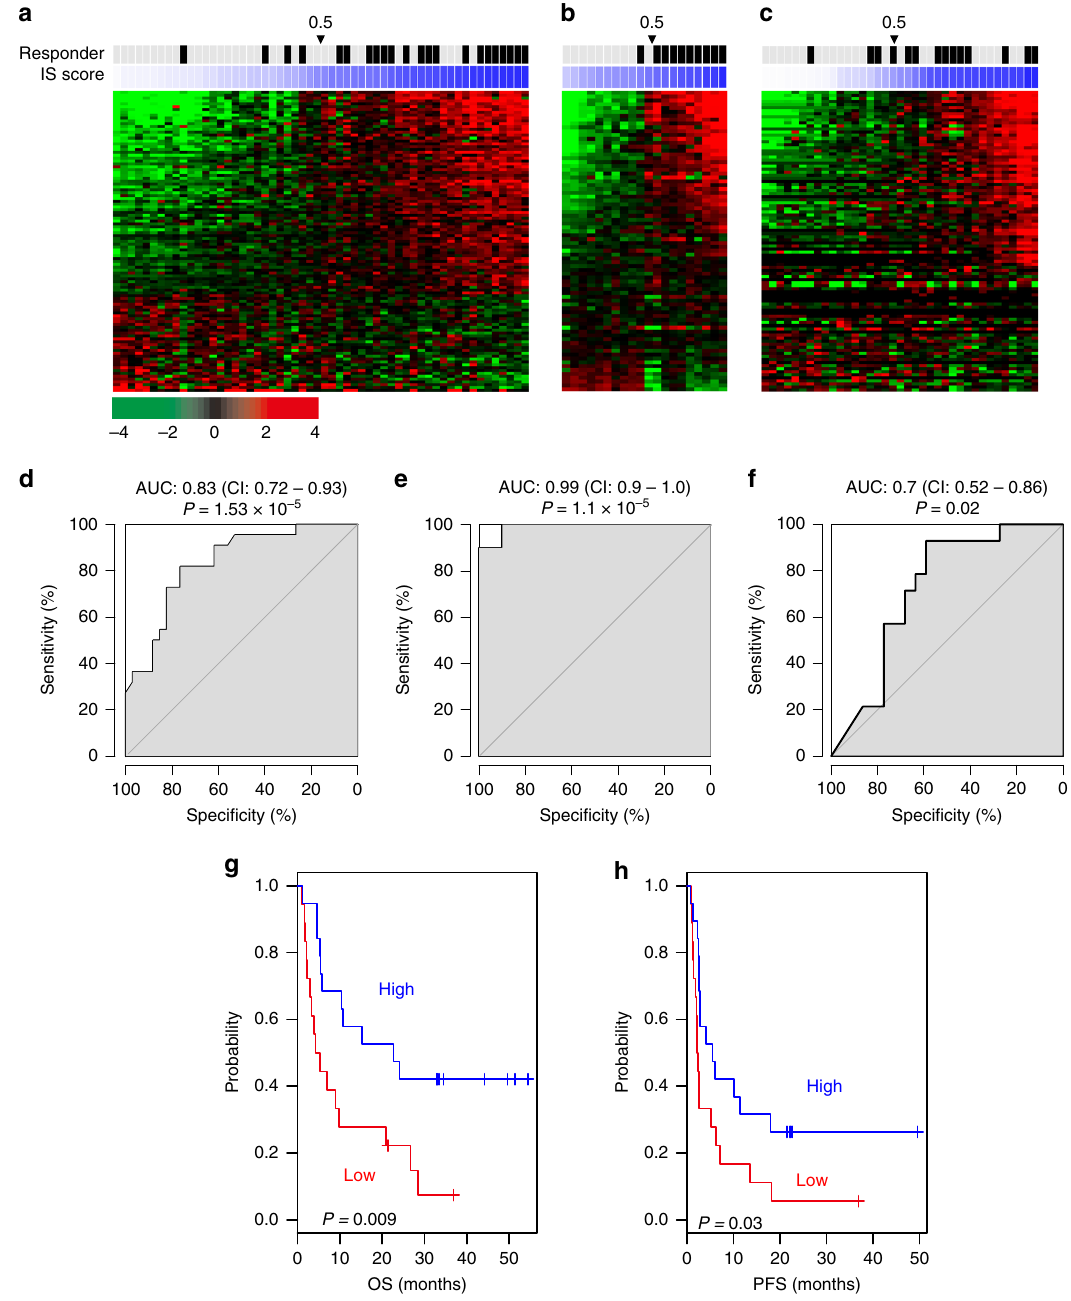
Fig. 1 Immune signature re fl ecting response to immunotherapy from human and mouse cancer tissues. a Expression patterns of genes signi fi cantly associated with response to immunotherapy in training cohort. Pretreatment biopsies from patients with metastatic melanoma were used to generate gene expression data. Genes whose expression is signi fi cantly different between responders and non-responders were selected (105 genes, P < 0.005 and 1.5-fold difference). The data are presented in matrix format, with rows representing the individual gene and columns representing each tissue. Each cell in the matrix represents the expression level of a gene feature in an individual tissue. Red and green re fl ect high-expression and low-expression levels, respectively, as indicated in the scale bar (log 2 transformed scale). Immune signature (IS) scores are presented as color index in blue (0 − 1 scale). b Expression patterns of immune signature genes and IS scores from mouse mesothelioma model treated with anti-CTLA-4 antibodies. c Expression patterns of immune signature genes and IS scores from human melanoma tissues treated with ipilimumab. d – f Receiver operating characteristics (ROC) analysis of IS scores from each prediction. Robustness of IS scores identifying responders to immunotherapy was estimated by area under curve (AUC) from ROC analysis. d Human melanoma treated with MAGE-A3 antigen, e mouse mesothelioma model treated with anti-CTLA-4 antibodies, f human melanoma treated with ipilimumab. (CI: 95% con fi dent internal of AUC). g , h Kaplan − Meier plots of overall survival (OS) and progression-free survival (PFS) of advanced melanoma patients treated with ipilimumab. Patients were strati fi ed according to IS scores (high > 0.5). See also Supplementary Figs. 1